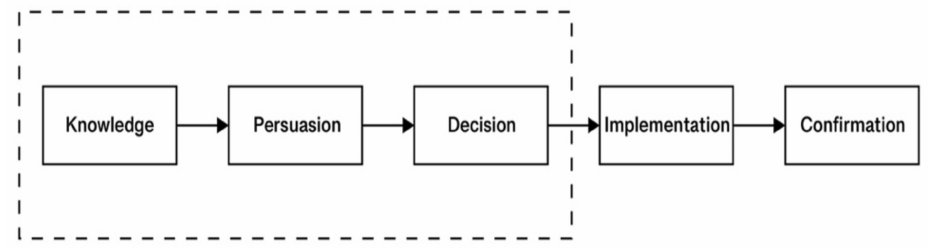
Figure 1. A Model of the Adoption Stage by